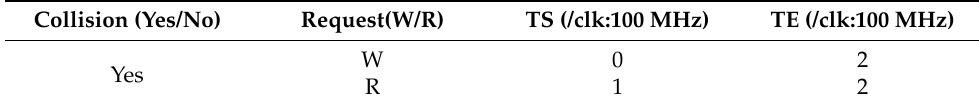
Table 5. The delay time of processing bus access in testing phase.